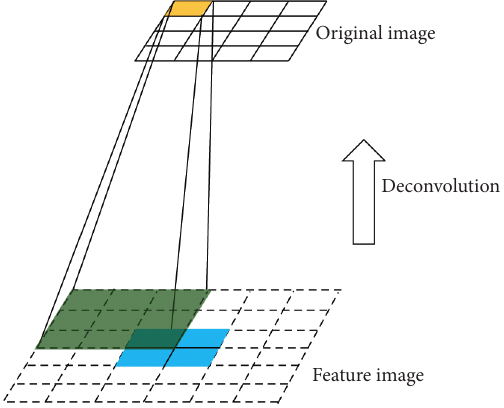
Figure 3: The process of